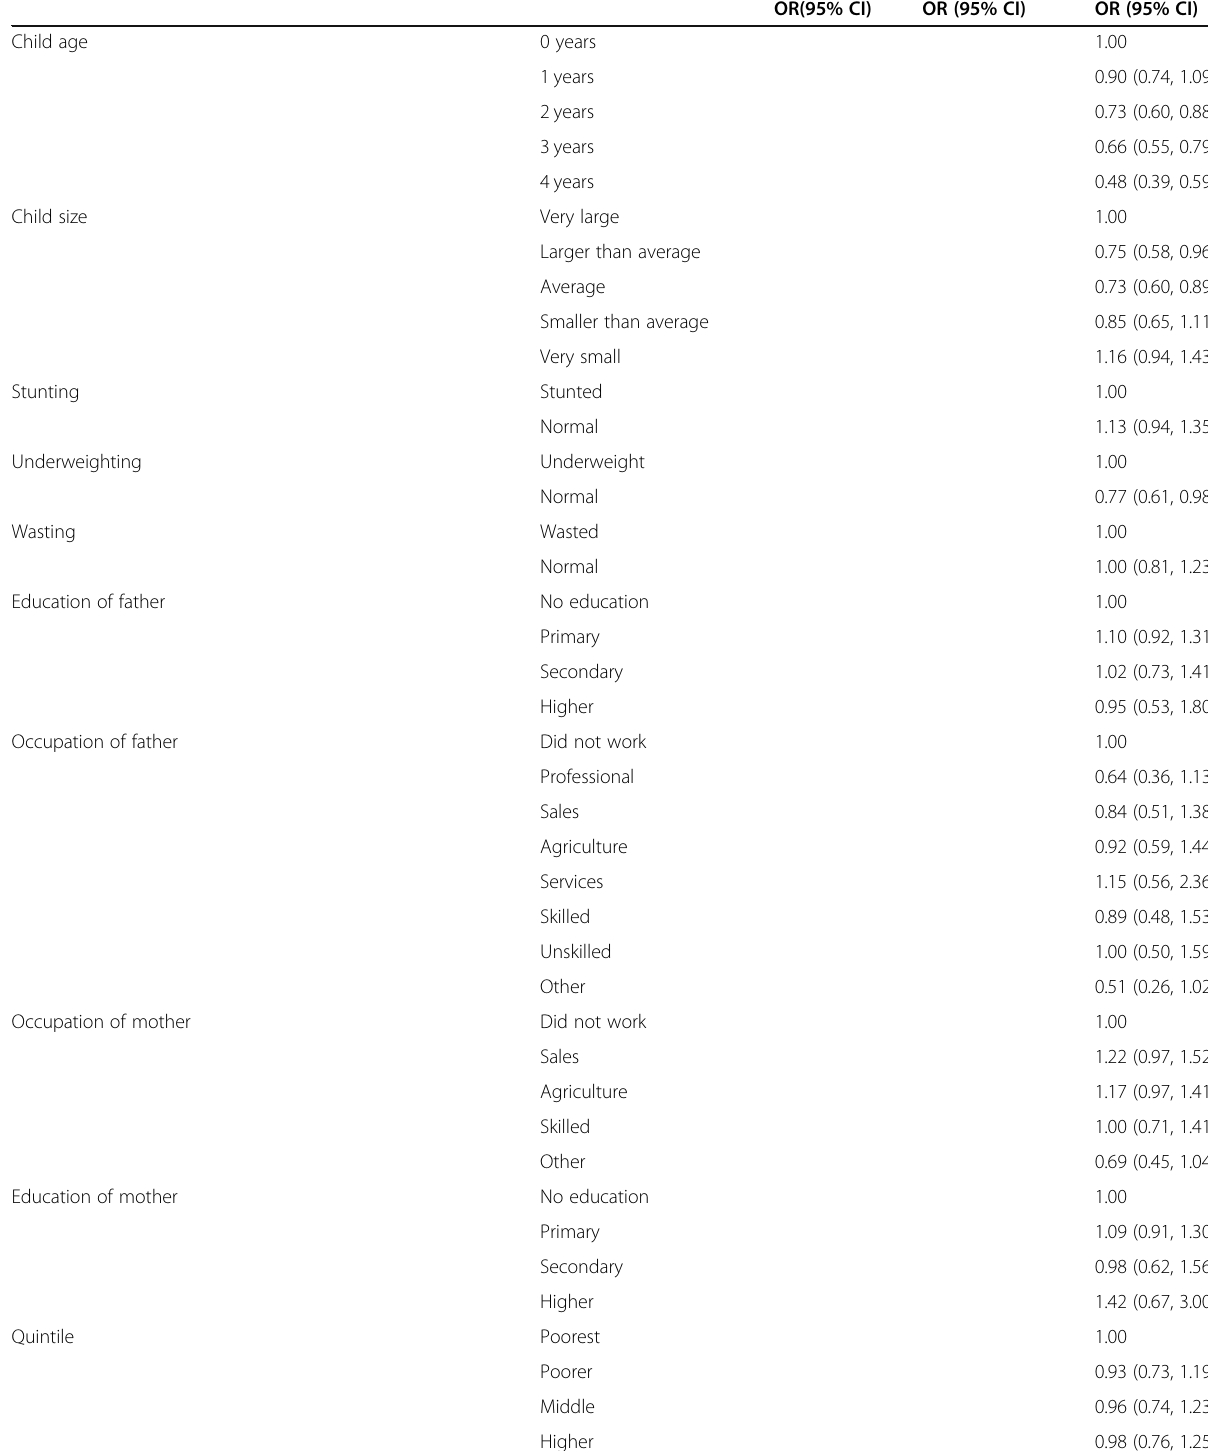
Table 3 Multilevel logistic regression on the association of food cooking places with ARI in under-five children in controlling other variables, EDHS, 2005 –